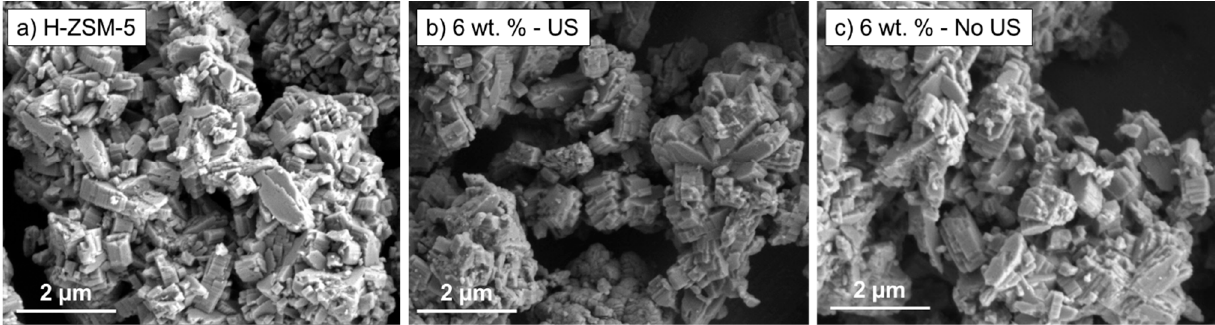
Figure 3. SEM images of the ( a ) parent zeolite H-ZSM-5 and Mo/ZSM-5 catalysts with 6 wt. % loading prepared, ( b ) with ultrasound (US) and ( c ) without ultrasound (No US).